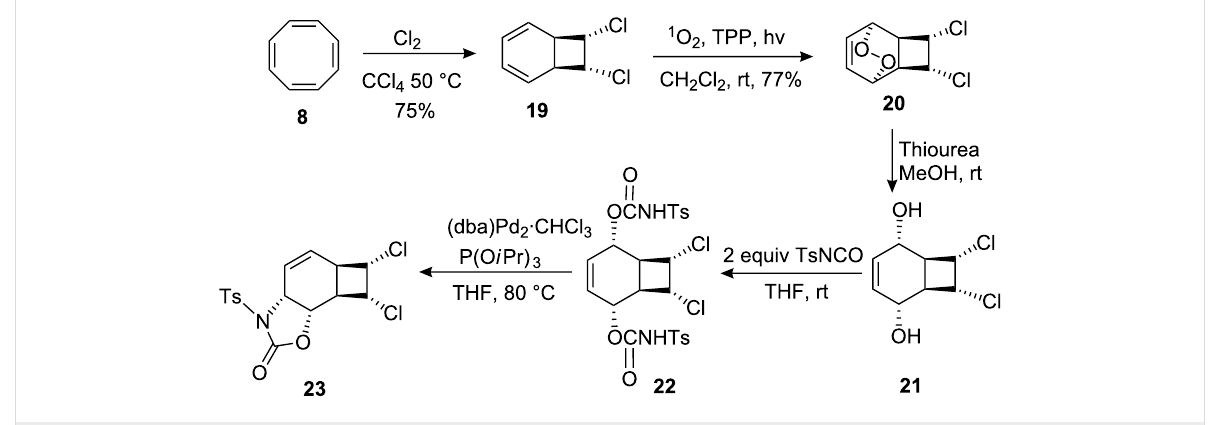
cis -Dichlorobicyclooctadiene 19 was synthesized from cyclooctatetraene 8 by the addition of chlorine following the lit- erature procedure [39]. Photooxygenation of cis -dichlorobicylo- octadiene 19 with singlet oxygen gave the expected endoper- oxide 20 [19-21] (Scheme 4). Since the dichlorobicycloocta- diene 19 has no plane of symmetry, singlet oxygen